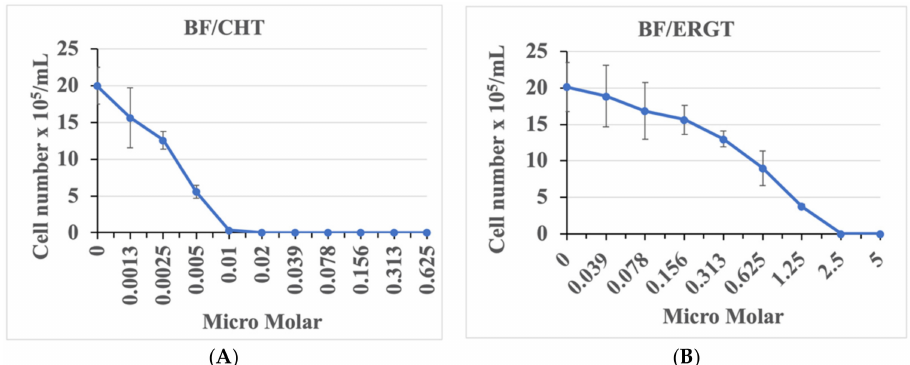
Figure 2. T. brucei cell growth at different concentrations of CHT and ERGT. T. brucei BF cells were inoculated at a cell density of 10 4 /mL in HMI-9 medium containing different concentrations of CHT (0–0.62 µ M) ( A ) and ERGT (0–5 µ M) ( B ). Cells were counted after 2 days. Cell numbers were plotted against the concentrations of drugs to determine the EC 50 of each compound for each type of